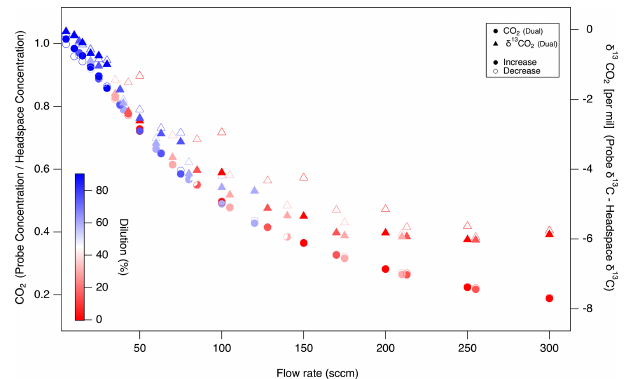
Figure 8. Impact of probe sampling flow rate on the fractional re- covery of true CO 2 concentrations (left axis, circles) and the offset in true soil δ 13 C (right axis, triangles) by probe gas sampling. As in Fig. 7, sequential probe flow rate increase (filled symbols) and de- crease (open symbols) tests are plotted together. Dilution corrected in System 1.